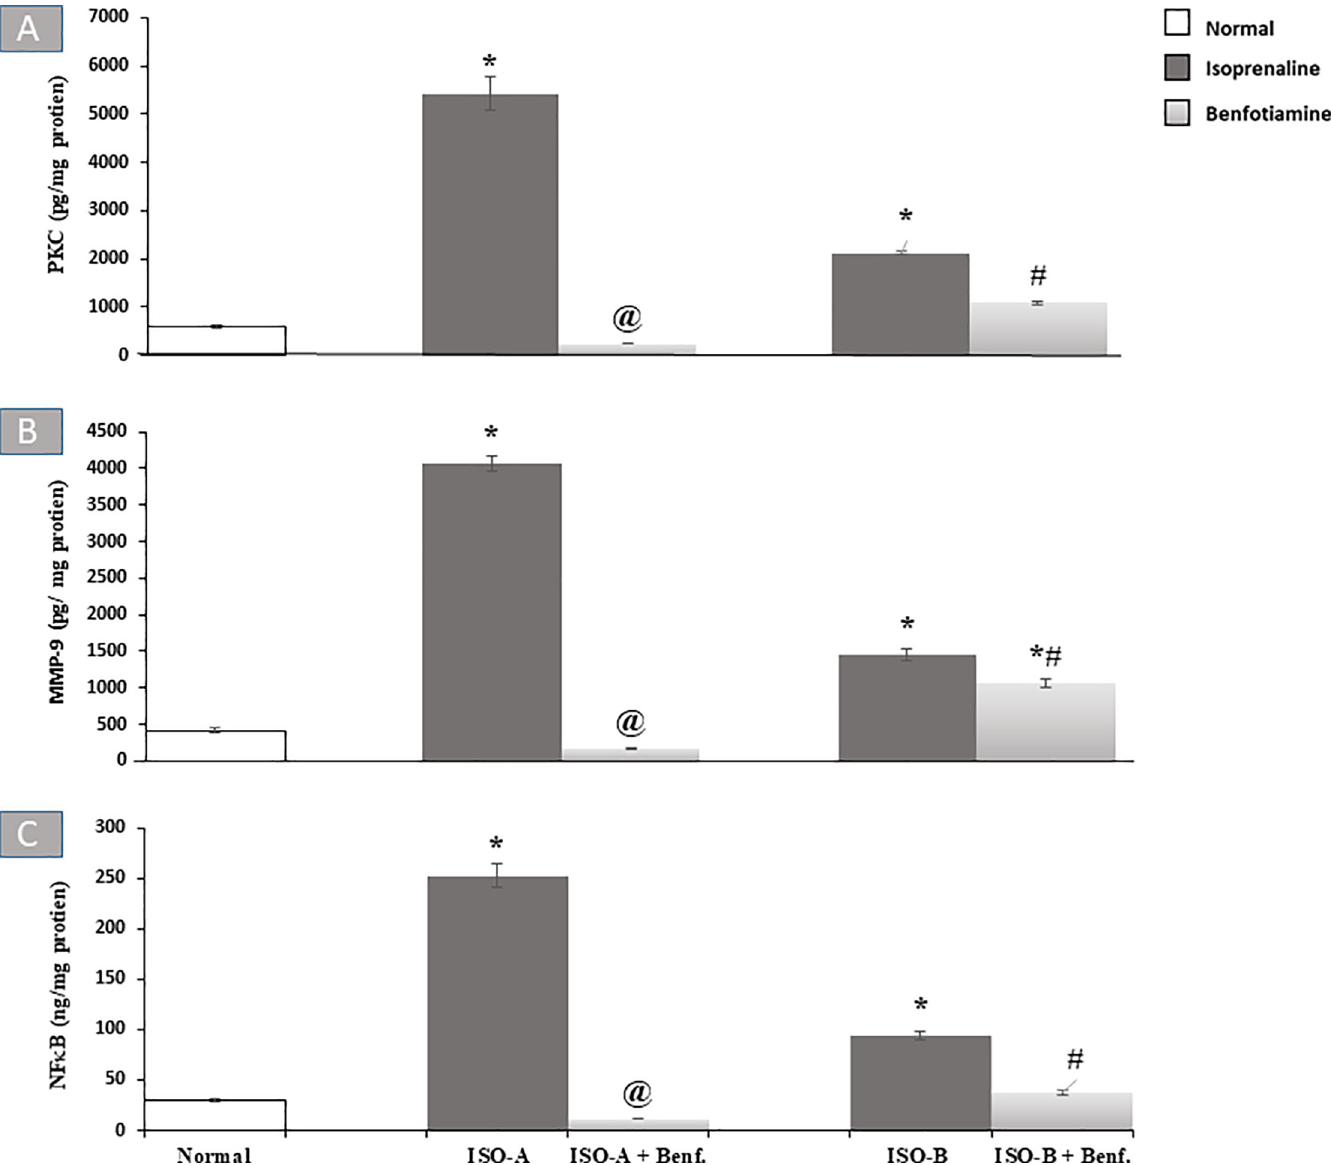
Fig 3. Effect of oral benfotiamine pre- and post-treatments on myocardial (A) PKC, (B) MMP-9 and (C) NF- κ B contents in ISO-induced MI in rats. Each bar represents mean ± SEM (n = 8). Statistical analysis was done using One-way ANOVA followed by Tukey’s post-hoc test. � significantly different from the normal group at p < 0.05. @significantly different from the ISO-A group at p < 0.05. #significantly different from the ISO-B group at p < 0.05. ISO-A: ISO pre-treatment control; ISO-B: ISO post-treatment control; ISO-A+ Benf.: benfotiamine prophylactic; ISO-A+ Benf.: benfotiamine treatment.